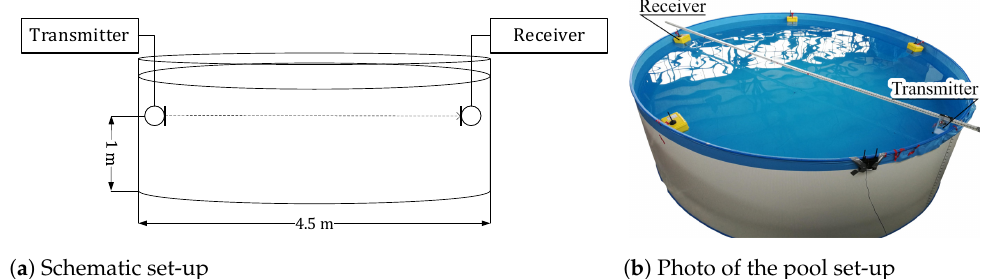
Figure 7. Schematic experimental set-up in for the acoustic transmission inside a water tank. The tank is filled with fresh water and located inside a closed building. A comparable scenario would be two divers working on a ship’s hull or an UAV inspecting a lake harbor’s foundations.